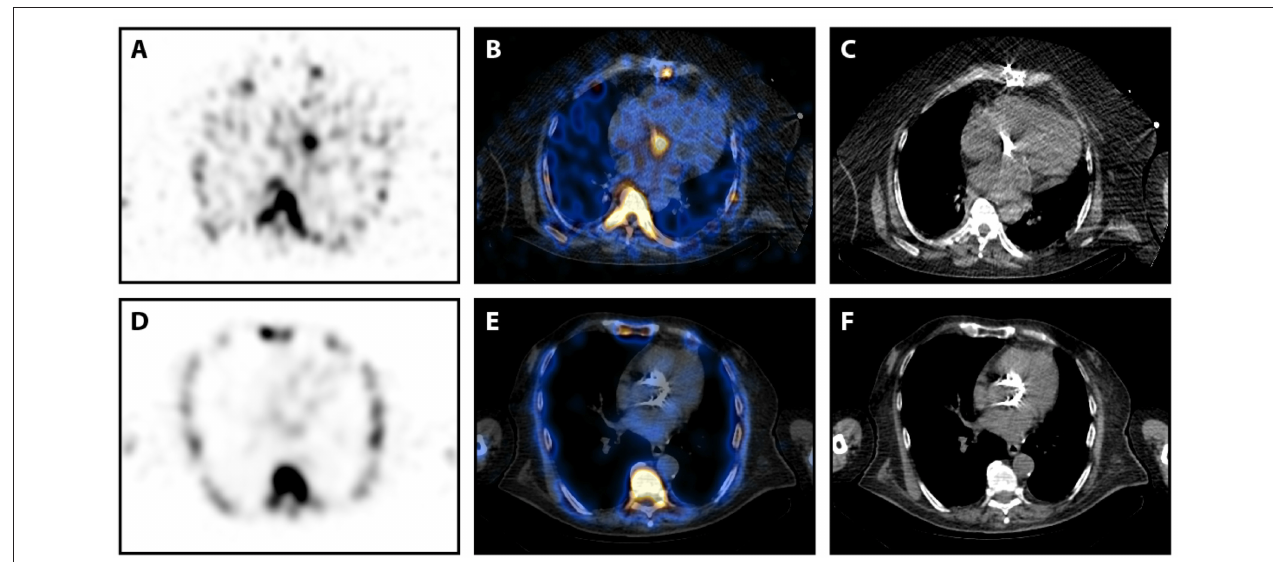
FIGURE 1 | 99m Tc-Besilesomab-SPECT/CT in patients with aortic valve prostheses. (A–C) SPECT/CT images in transversal view of a 63-years old male patient with suspected prosthetic valve infection 5 years after an aortic valve replacement. Blood cultures detected Staphylococcus aureus and TEE suspected an abscess formation. SPECT showed a distinct focal uptake at the aortic valve level (A) . This focal uptake could be localized around the prosthetic valve in fused images (B) . (C) Non-fused CT image of the prosthetic valve. Pathology results confirmed infection of the prosthesis. (D,E) SPECT/CT images in transversal view of an 82-years old male patient with suspected prosthetic valve infection 3 years after a transcatheter aortic valve implantation. Blood cultures were negative and TEE was inconclusive. SPECT did not detect any pathological uptake (D) , especially around the aortic valve replacement (E) . (F) Non-fused CT image of the prosthetic valve. Endocarditis was excluded by clinical findings according to the Duke criteria.